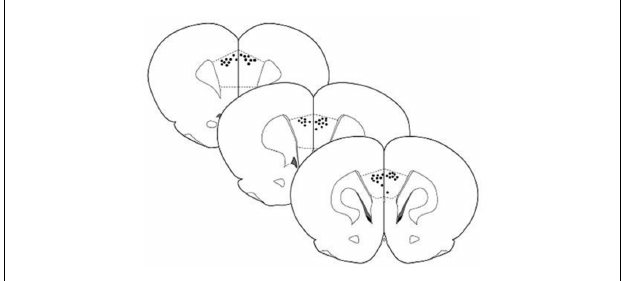
FIGURE 1 | Schematic drawing of coronal sections of rat brain showing the location of cannula tips used for micro infusions into the mPFC. Sections correspond to the atlas of Paxinos andWatson (2005).